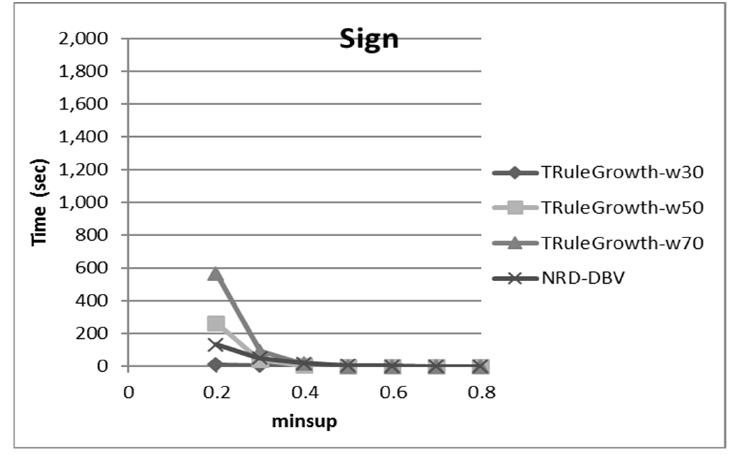
Figure 7. Comparison of the runtime of the TRuleGrowth with the NRD-DBV for (Sign) dataset .